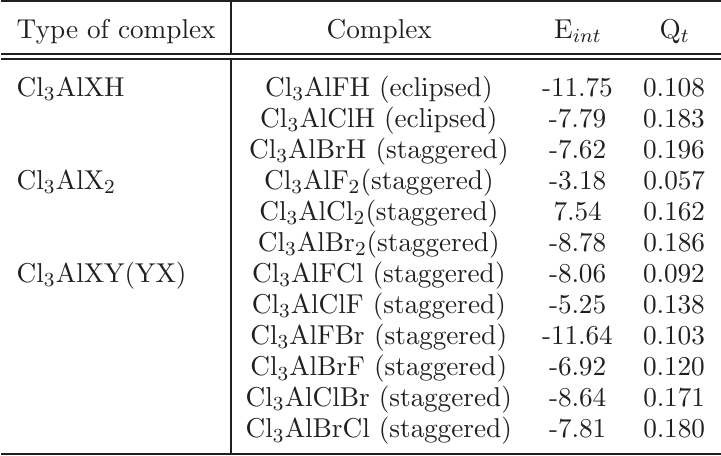
Table 8 Interaction energies E i nt (kcal/mol) of the stable complexes Cl and Cl AlXY(YX) (X = Y = F, Cl, and Br), and charge transfer Q t 3